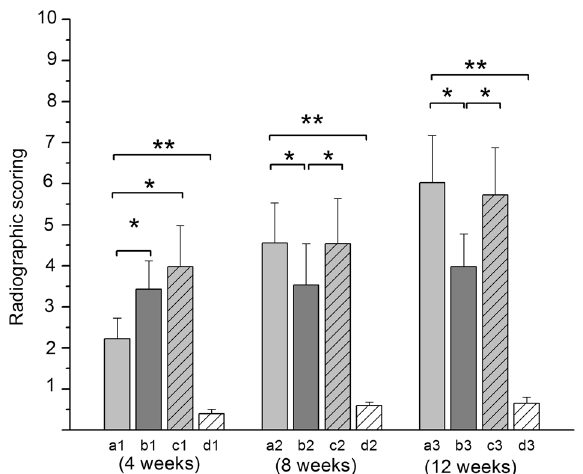
Fig. 6 Histograms of radiological scores between each group at 4, 8 and 12 weeks. The letters a1 , a2 and a3 represent Group A at 4, 8 and 12 weeks, respectively. In the same way, b1 , b2 , b3 , c1 , c2 , c3 and d1 , d2 , and d3 represent Groups B, C and Group D at 4, 8, and 12 weeks, respectively. Values are expressed as the mean ± S.D.; n = 12 per group. “ * ” and “ ** ” represent signi fi cant differences between the different groups at the same time (* P < 0.05 and ** P <